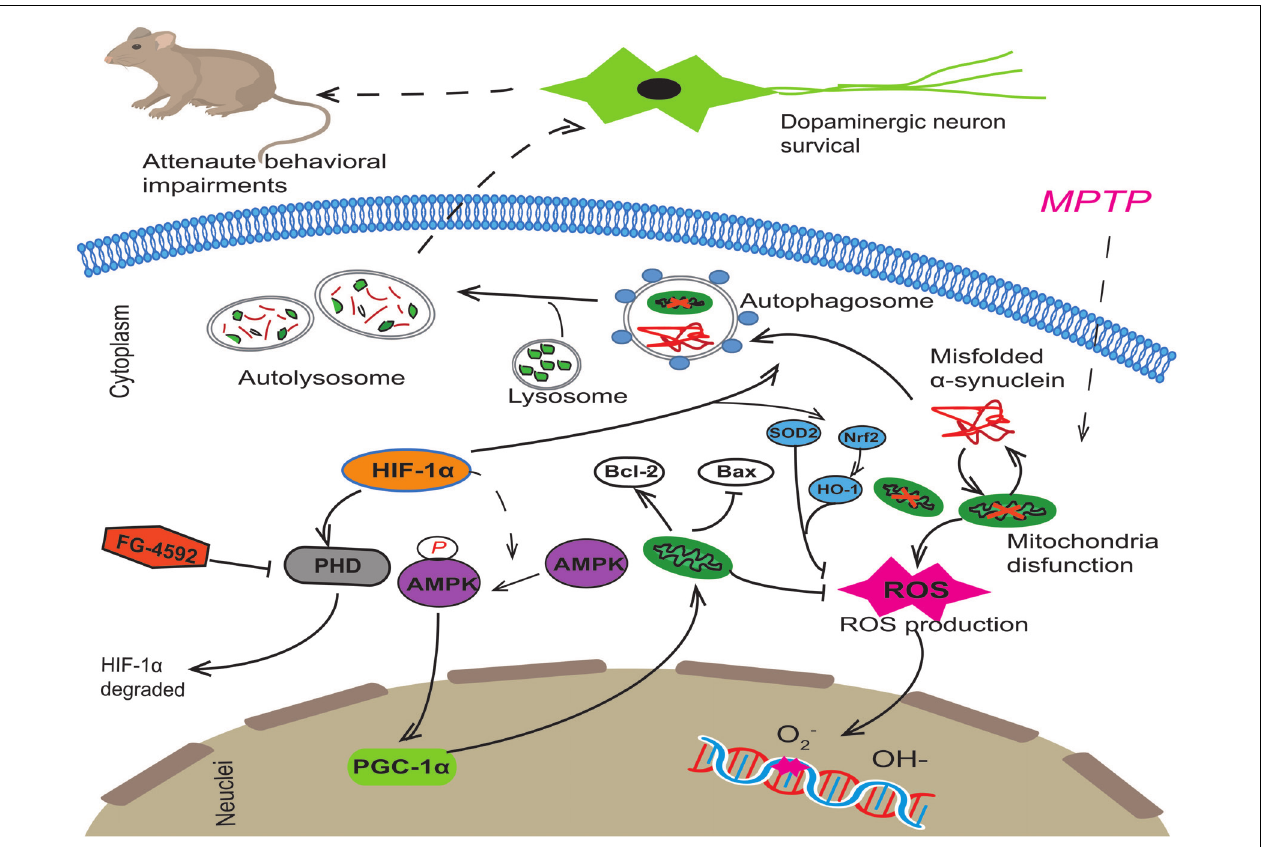
FIGURE 8 | FG-4592 activated HIF-1 α by inhibiting PHD and decrease its degradation. Activated HIF-1 α could increase the protein level of p-AMPK and then induced the expression of PGC-1 α . It also enhanced autophagy, which can remove damaged mitochondria and misfolded proteins in Dopaminergic neurons. This promoted the function of mitochondria, reduced cell apoptosis and decreased the production of ROS, which rescued the MPTP-induced loss of dopaminergic neurons, finally attenuating the behavioral impairments of MPTP-treated